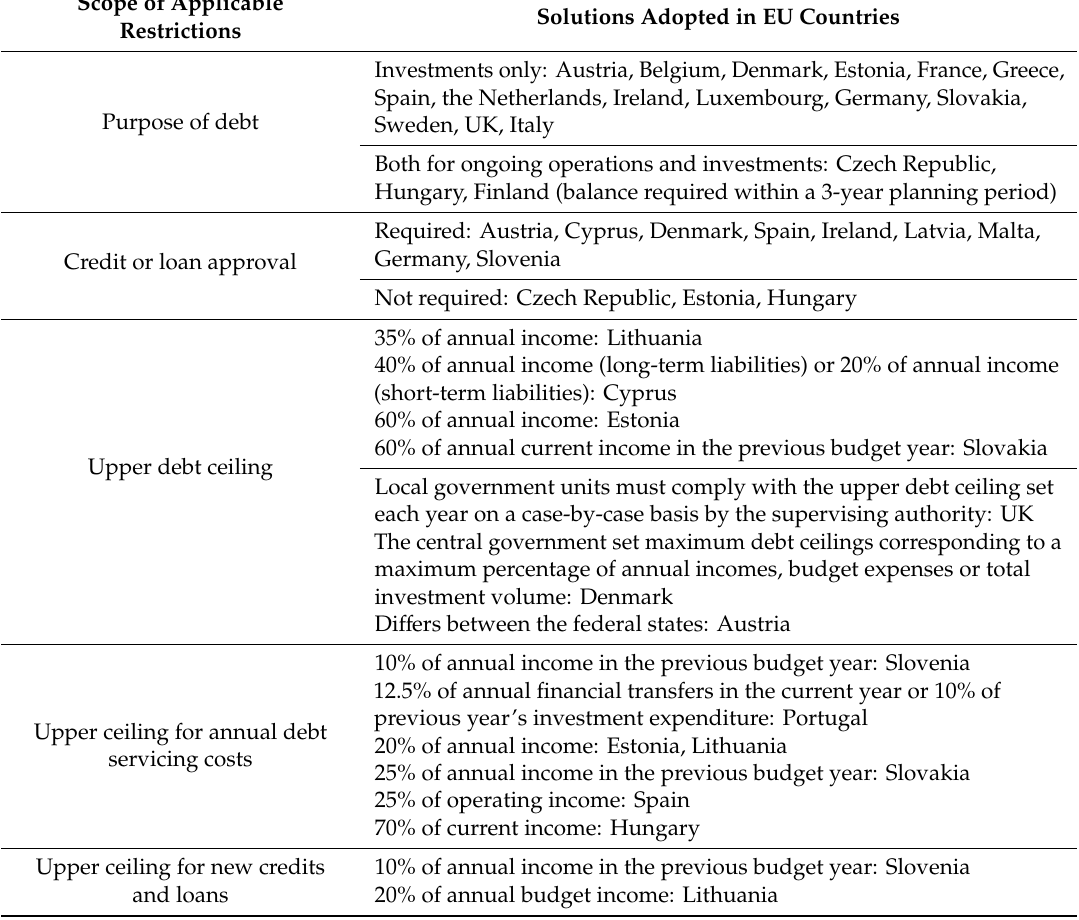
Table 1. Restrictions on the local government units’ capacity to incur debt, as applicable in the European